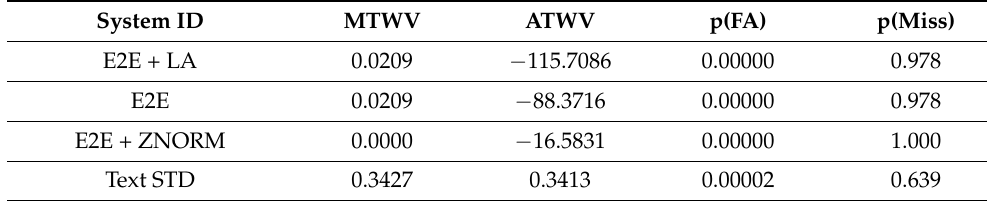
Table 16. System results of the QbE STD task for RTVE test data.